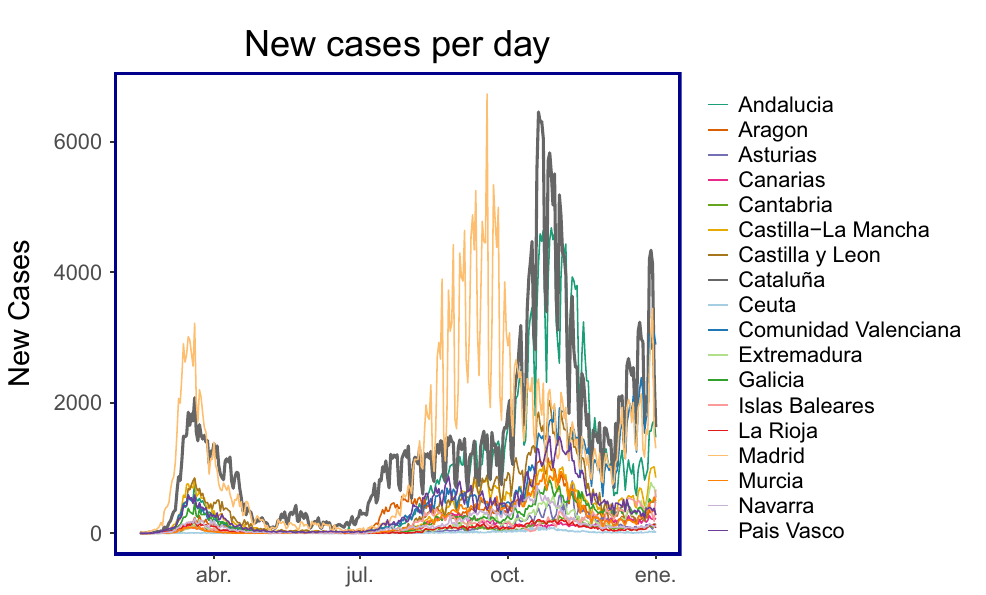
Figure 2. New cases per day for each CCAA: number of COVID19 cases for each autonomous community (CCAA) in Spain. Madrid experienced its second peak before the rest of Spain, with Cataluña (as the bold line) experiencing its second peak just after. The policy was a direct response to control the outbreak of the second peak in Cataluña. On the x-axis, ene refers to Enero